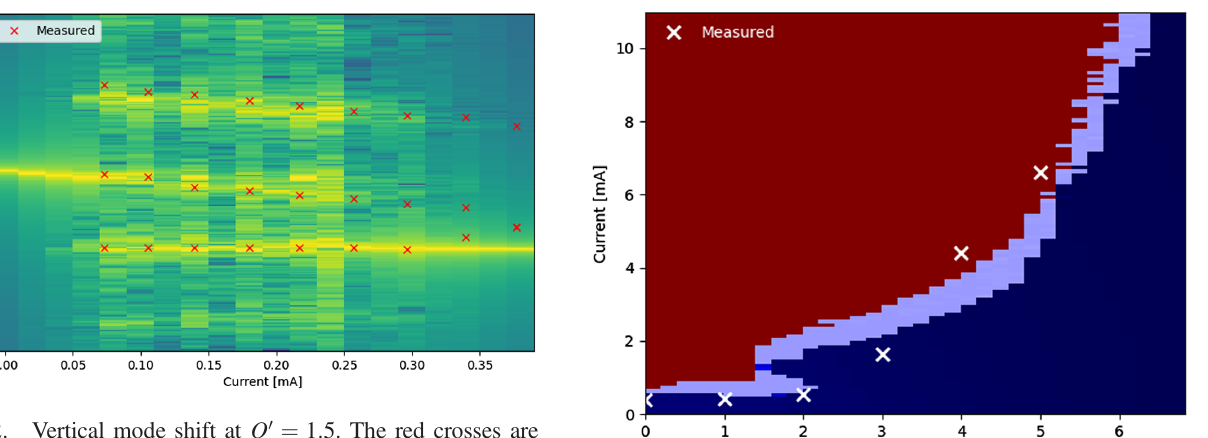
FIG. 12. Vertical mode shift at Q 0 ¼ 1 . 5 . The red crosses are peaks coming from the measured spectrum, whereas the colored background is the simulated spectrum.